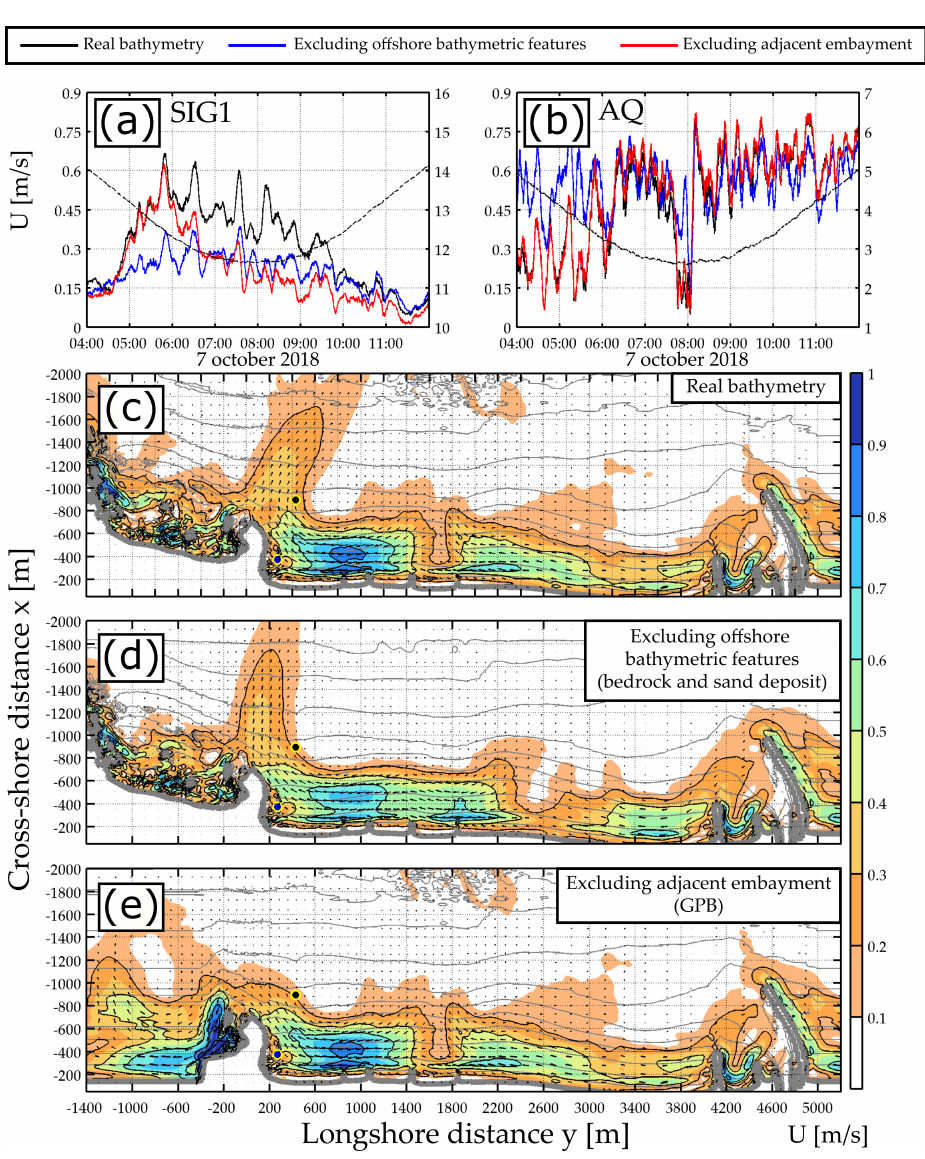
Figure 10. Model output at low tide of event D2 for three bathymetries: real bathymetry, excluding offshore bathymetry features and excluding the adjacent embayment. Top panels: modelled 5 min- running averaged velocity magnitudes during the first low tide of event D2 at SIG1 ( a ) and AQ ( b ) locations. Bottom panels ( c–e ): modelled mean velocity field plotted on the magnitude contours (0.2-m/s spaced; black lines) and the bathymetry contours (2-m spaced; grey lines), averaged at low tide of event D2. The black and blue points indicate SIG1 and AQ locations,